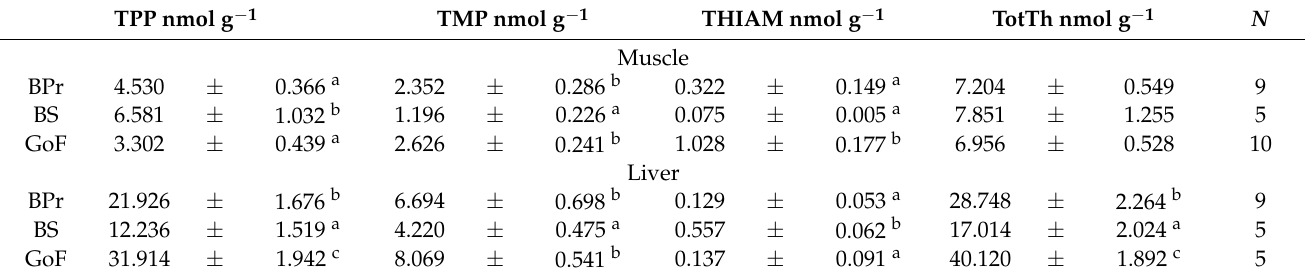
Table 2. Mean ( ± SE) concentrations of thiamine pyrophosphate (TPP), thiamine monophos- phate (TMP), free thiamine (THIAM), and total thiamine (TotTh) in the muscle and liver of salmon ( Salmo salar ) caught in the Baltic Proper (BPr), Bothnian Sea (BS), and Gulf of Finland (GoF) of the Baltic Sea in the late fall during feeding migration. N = number of